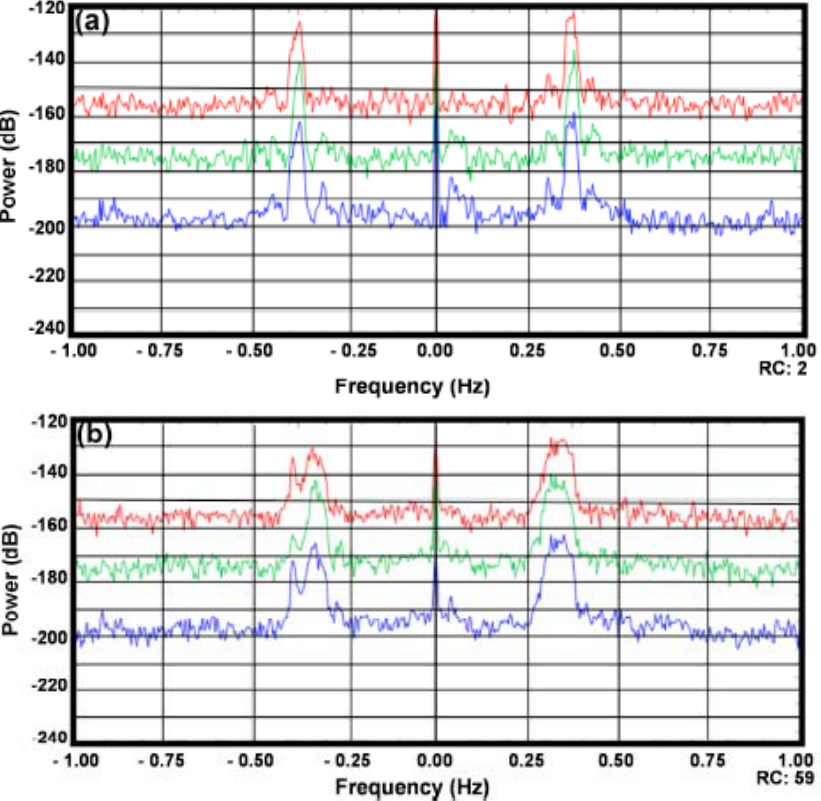
Figure 4. Radar echo spectra measured by an HF radar receiver located at Commonweal, California on April 02, 2008 23:10 (a) backscatter spectra, range cell 2; (b) bistatic echo spectra from the transmitter at Fort Funston, range cell 59.